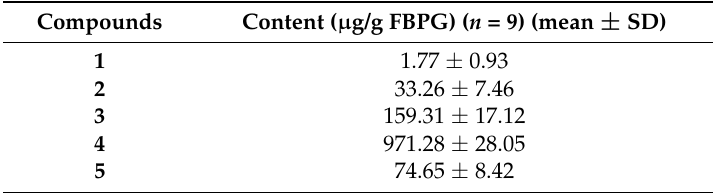
Table 6. The content of the five less polar ginsenosides in